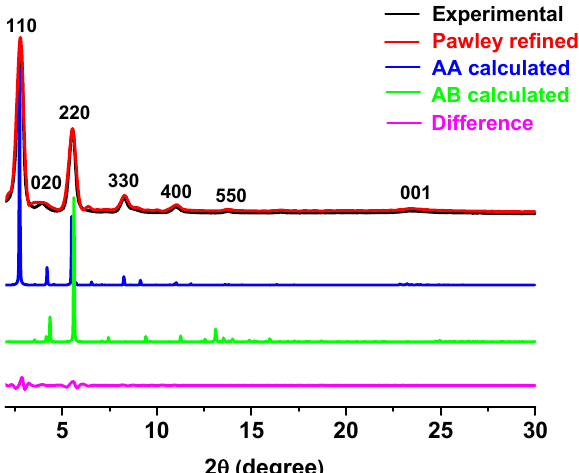
Figure 1. PXRD patterns of IM4F-Py-COF. Experimental pattern (black), profiles simulated using the Pawley refinement (red), the difference between experimental and refined patterns (magenta), AA-stacking (blue) and AB-stacking (green) modes of the IM4F-Py-COF.